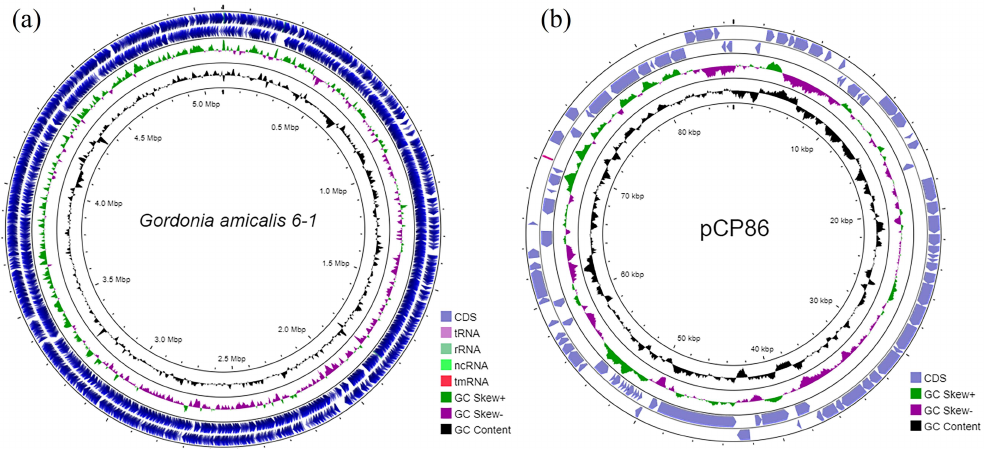
Figure 1. Graphical maps of circular chromosome ( a ) and plasmid pCP86 ( b ) of G. amicalis